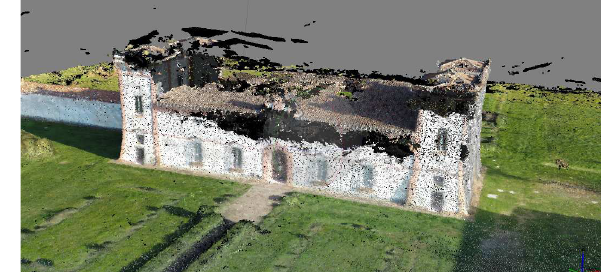
Figure 14: Point clouds obtained using undistorted photos (dataset 01)